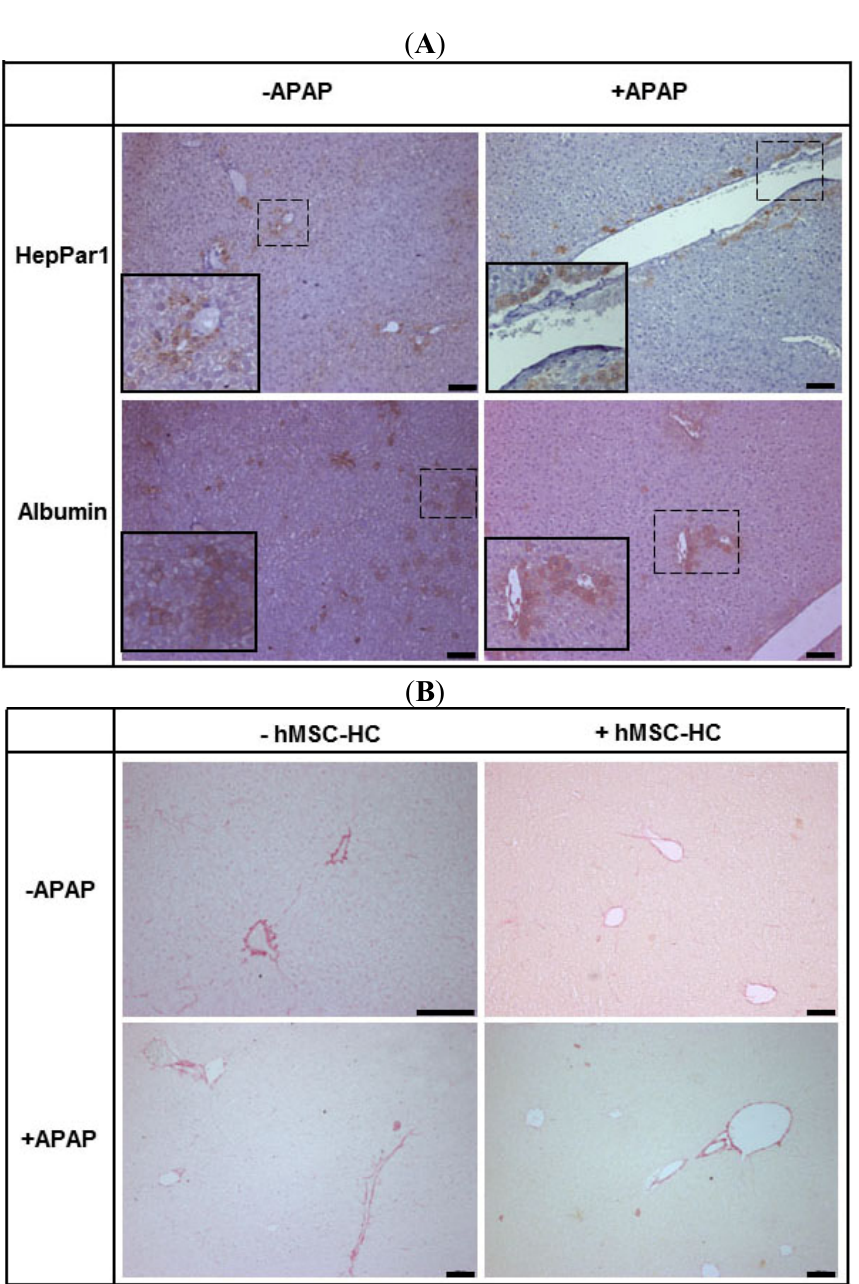
Figure 9. Functional integration of hMSC-HC into mouse livers treated with and not treated with APAP. Animals were treated with APAP (+APAP) or with PBS as a control ( − APAP). Twenty-four hours later, hMSC-HC were transplanted into the livers as indicated (+hMSC-HC) and described in Materials and Methods. Controls received PBS instead ( − hMSC-HC). Seven weeks later, livers were explanted and human stem cell-derived hepatocytes were detected immunohistochemically in the mouse liver parenchyma by the use of human anti-HepPar1 and human anti-albumin antibodies ( A ). In ( B ), collagen was stained histochemically by the Sirius red method as described in Materials and Methods. Scale bar: 100 µm; the insets in ( A ) show higher magnifications of the dotted